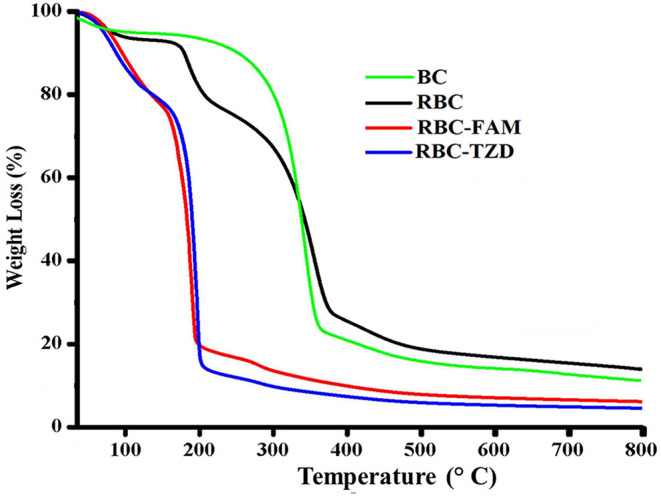
Curves of the thermogravimetric analysis for the prepared matrices of R-BC, R-BC-famotidine, and R-BC-tizanidine.